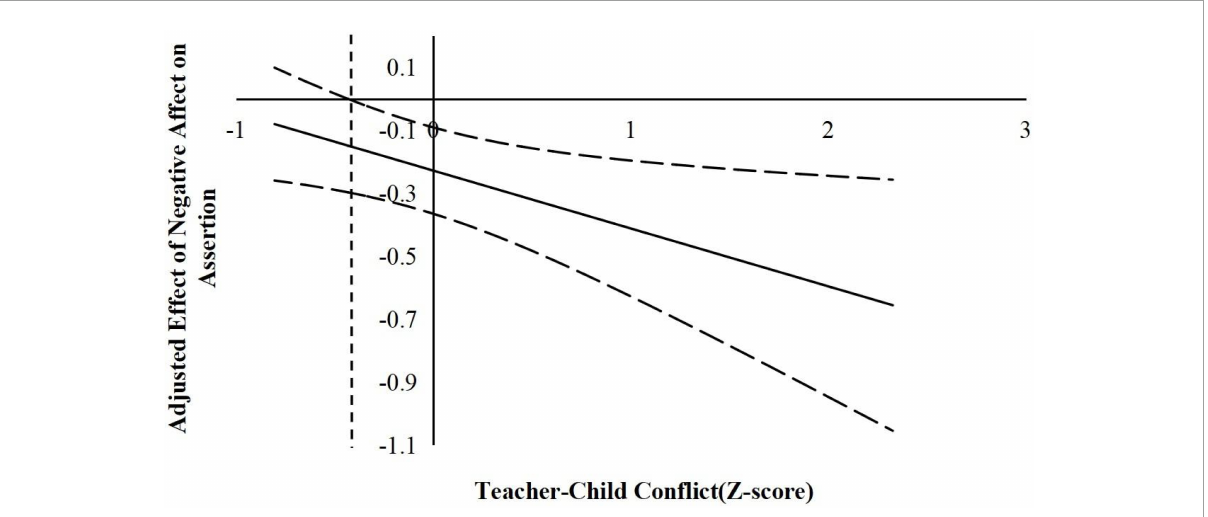
FIGURE6 The moderating effect of teacher-child conflict in the prediction of children’s negative affect on the assertion. The dashed vertical line indicates the point along the teacher-child conflict in which the negative affect regression coefficient transitions from significance (right of the dashed vertical line) to non-statistical significance (left of the dashed vertical line). The value of the dashed vertical line was